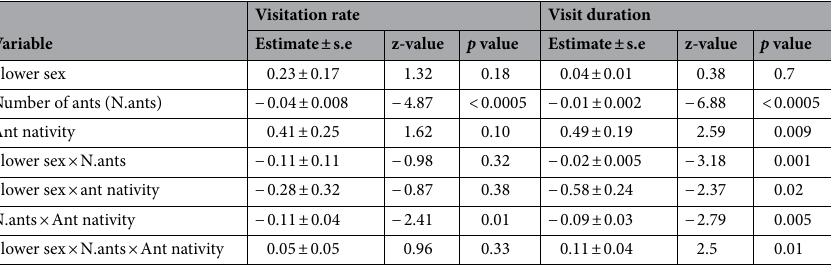
Table 2. The GLMM models used to examine whether ant nativity (invasive vs. native), ant abundance and flower sex (pistillate vs. staminate) affect visitation rate and visit duration of pollinators on pumpkin flowers individually or in interaction among themselves. Negative binomial distribution fitted as error type in the